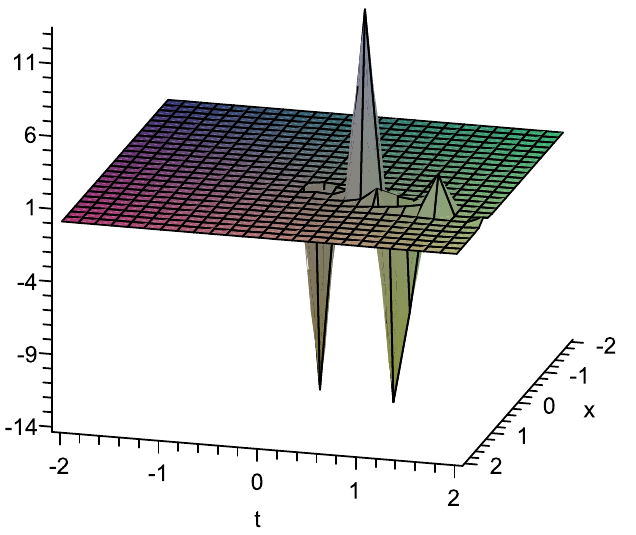
in (58); α is a beta distribution 9